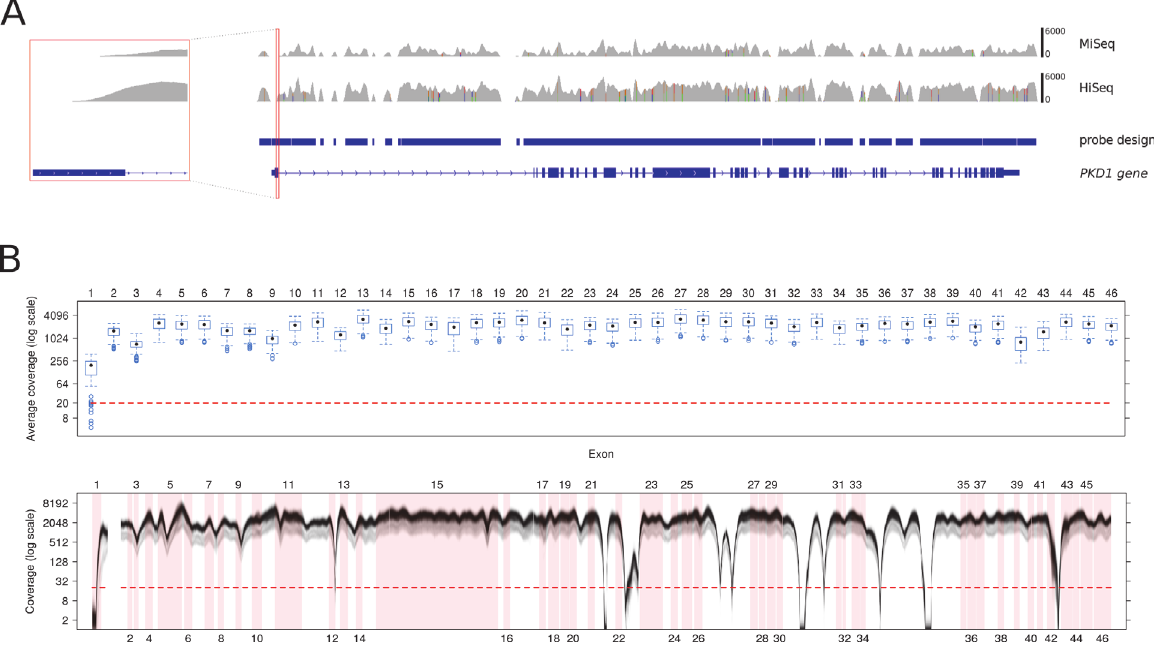
Fig 1. Probe design for the PKD1 locus and coverage of the PKD1 genomic and coding region. A. Coverage of the PKD1 target region corresponds to probe design being nearly complete for the coding region with gaps in intronic segments. The red inbox (zoom) illustrates coverage of exon 1 with MiSeq and HiSeq sequencing showing the only obvious performance difference in this segment. B. The boxplot illustrates variation of the average coverage for each PKD1 exon over all 55 samples of the validation cohort (log scale). The box boundaries mark the upper and lower quartiles, and whiskers extend to the most extreme data point in the 1.5-fold interquartile range. Outliers outside that range are displayed as a dot. In all exons except exon 1, a minimum coverage of > 20x (red dashed line) is achieved even for the MiSeq samples as sufficient prerequisite for diagnostic testing. The levelplot below shows the coverage distribution of all samples by base position (intron 1 is omitted). The color intensity of each spot reflects the number of samples at that position, with a darker shading indicating more samples at that position. Exons are marked by red boxes. Except for exon 1, all samples at all exonic base positions have a coverage above 20x (red dashed line). MiSeq and HiSeq samples are mixed in that figure, therefore a shadowed grey area below the black main graph can be observed which makes up the MiSeq samples with a lower coverage in general.